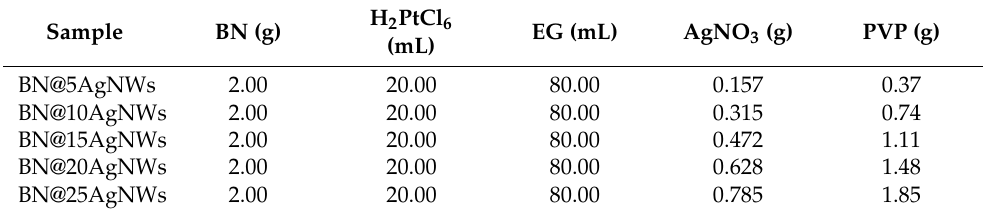
Table 1. Formula for